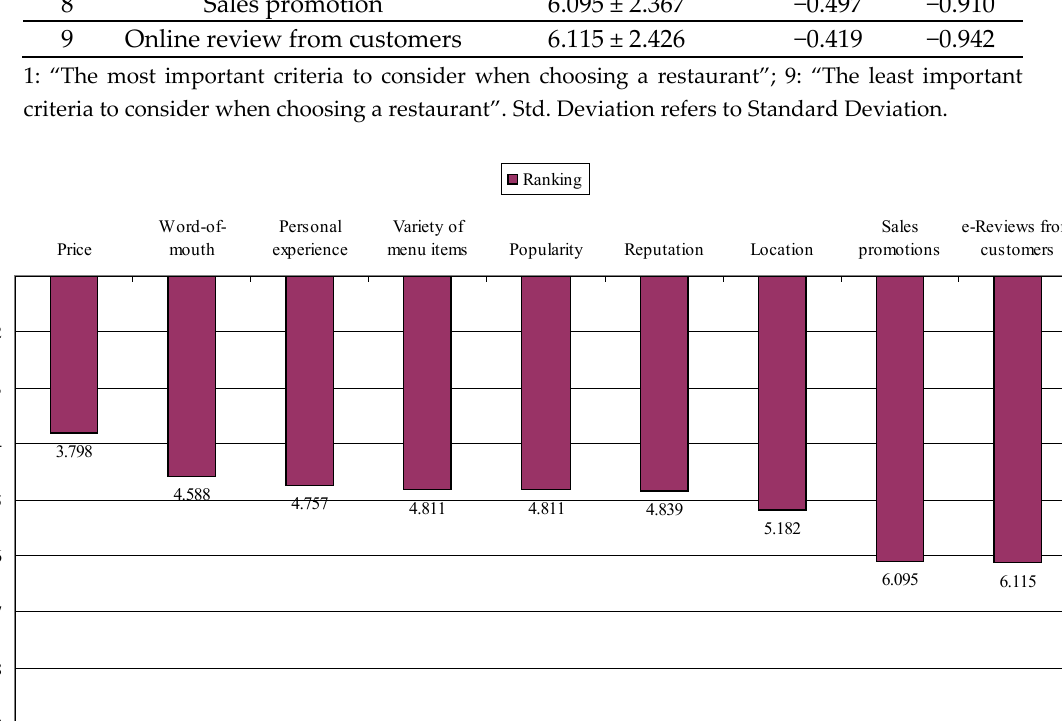
Figure 1. Overall ranking. The most/least important factor when choosing a restaurant. The value “1” indicates the most important criteria to consider when choosing a restaurant, and the value “9” indicates the least important criteria. Thus, the figure shows that “price” which is closer to “1” as compared to other variables is ranked the most important factor that patrons consider when selecting a